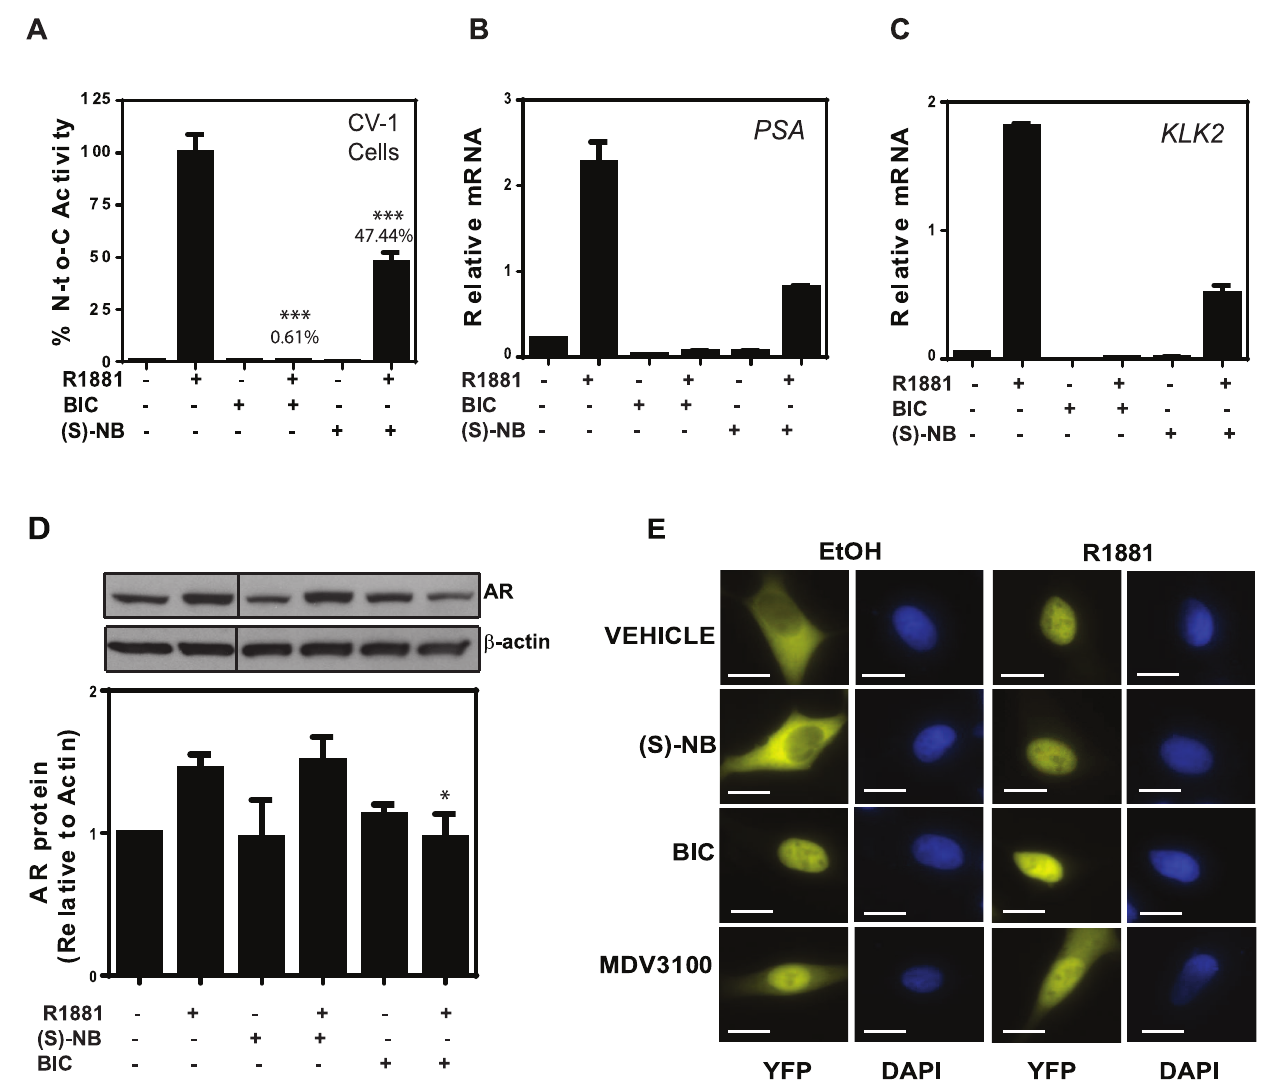
Figure 3. Niphatenones block N/C interaction and inhibit expression of AR regulated genes. (A) Mammalian two-hydrid assay using CV1 cells transfected with GAL4-AR DBD and/or VP16-AR TAD and Gal4-luciferase reporter. Cells were pretreated for 1 hour with bicalutamide or ( S )- niphatenone B before addition of R1881 for 24 hours. Data represent the mean 6 SEM of n=3 separate experiments with triplicate wells. Student’s t test: *** P , 0.001. (B) PSA/KLK3 or (C) KLK2 mRNAs were inhibited by ( S )-niphatenone B. LNCaP cells were pre-treated for 1 hour with ( S )-niphatenone B, bicalutamide or vehicle prior to 16 hours incubation with R1881. Data represent the mean normalized expression (MNE) of PSA or KLK2 transcripts normalized to levels of GAPDH transcripts. Representative data of n=3 separate experiments. * P , 0.05, **P , 0.01, *** P , 0.001 (Student’s t -test). (D) ( S )-niphatenone B does not decrease endogenous AR levels in LNCaP cells. Cells were pre-treated for 1 hour with ( S )-niphatenone B, bicalutamide or vehicle prior to the addition of R1881 for an additional 16 hours incubation before harvesting and Western blot analysis for AR and b -actin protein levels. Samples were run on the same gel but were not contiguous (black Lines) Error bars represent the mean 6 SD of n=3 separate experiments. Student’s t test: ***p , 0.001. (E) Nuclear translocation of YFP-AR in LNCaP cells transfected with an expression plasmid encoding an AR-YFP fusion protein in serum-free conditions for 24 hours prior to pre-treatment with ( S )-niphatenone, bicalutamide, vehicle (DMSO), MDV3100, or R1881 for 2 hours. DAPI staining indicates the location of the nucleus. Scale bar, 20 m